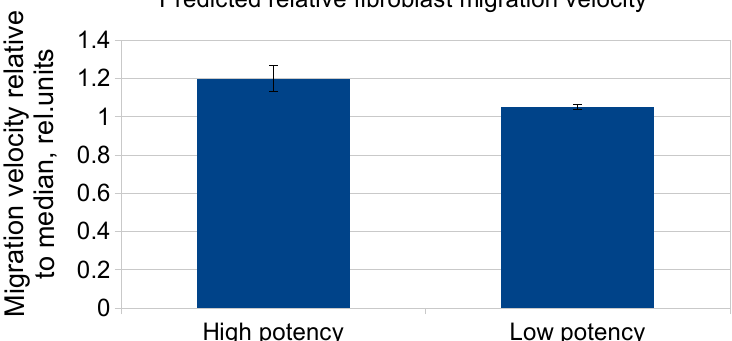
Figure 5. Comparison of two groups of MSC-CM samples that differed in potency. The data are presented as medians, 25th, and 75th percentiles, p < 0.086 between these groups, n = 10 for High potency group, n = 2 for Low potency group.